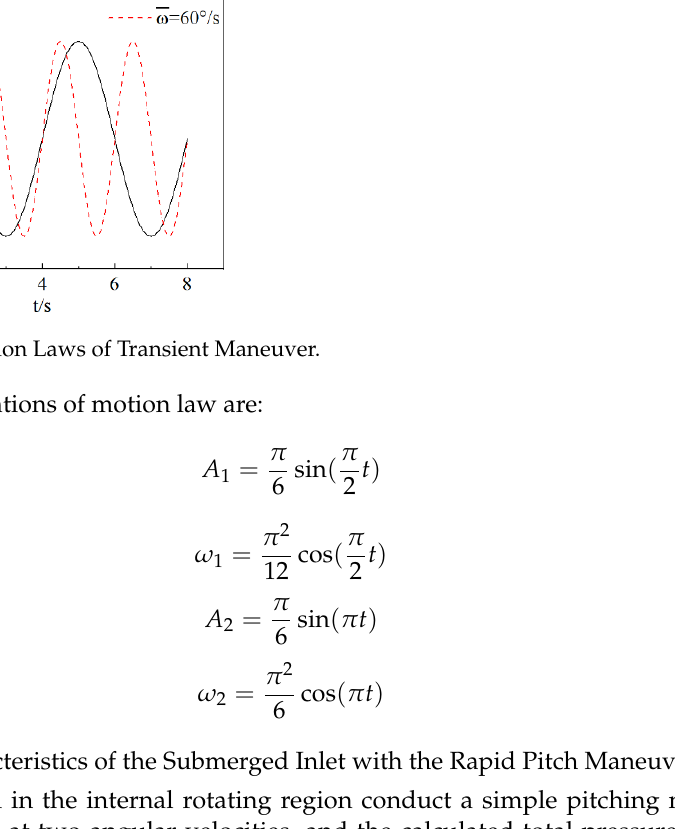
Figure 13. Two Motion Laws of Transient Maneuver.